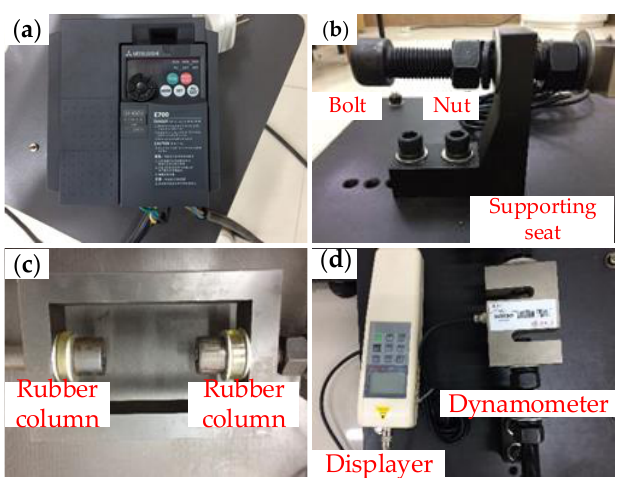
Figure 5. Bearing test rig.